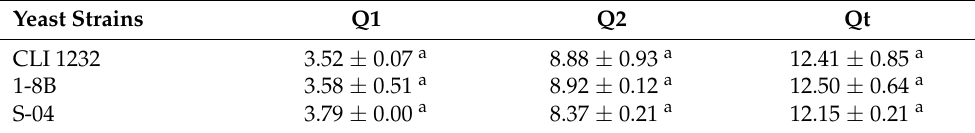
Table 5. Antioxidant activity of the selected sour beers and control strain in 1 L fermentation. Yeast Strains Q1